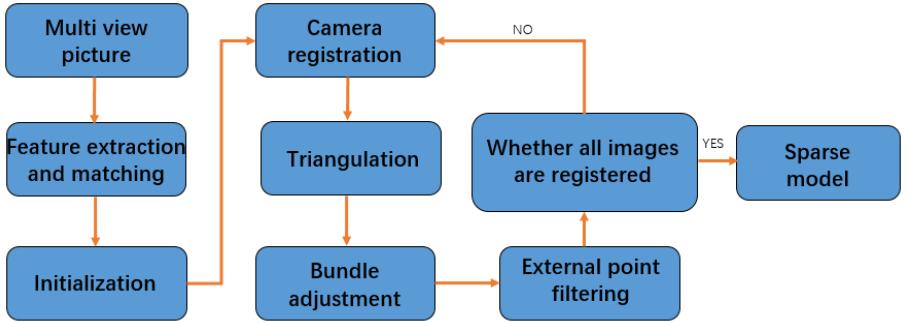
Figure 1. The flow chart of an incremental SFM algorithm. The flow chart of an incremental SFM algorithm is shown in the Figure